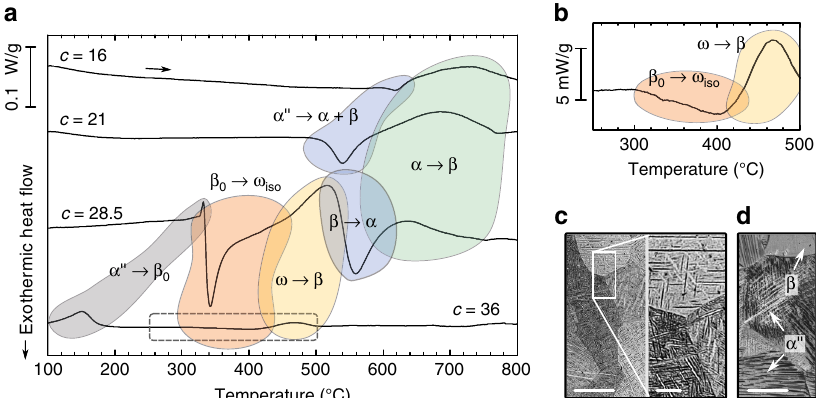
Fig. 1 Overview of heating-induced transformation behaviour. a Isochronal heat fl ow curves recorded during heating of martensitic Ti – (16, 21, 28.5, 36)Nb alloys at 10 °C min − 1 . b Close-up view of Ti – 36Nb in the interval enclosed by the dashed lines in ( a ). Differential-scanning calorimetry curves were adapted from previous studies 22, 24 . Light microscopy images of homogenized and quenched c Ti – 28.5Nb and d Ti – 36Nb illustrate the fully α ″ -martensitic microstructure for c = 16, 21, 28.5 and the partially austenitic microstructure for c = 36. The scale bars of the low magni fi cation images in ( c ) and ( d ) are 200 µ m and that of the magni fi ed portion in ( c ) is 50 µ